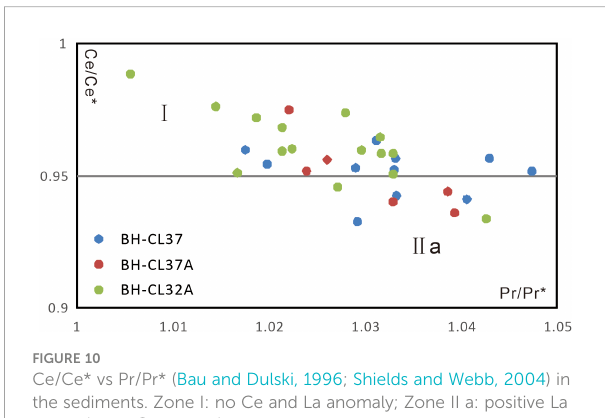
FIGURE 10 Ce/Ce* vs Pr/Pr* (Bau and Dulski, 1996; Shields and Webb, 2004) in the sediments. Zone I: no Ce and La anomaly; Zone II a: positive La anomaly, no Ce